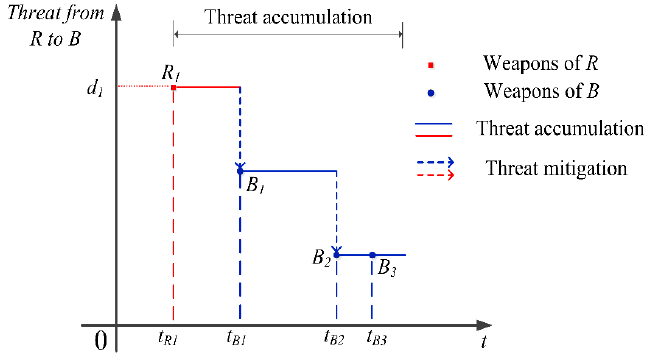
Figure 4. Threat accumulation over time.